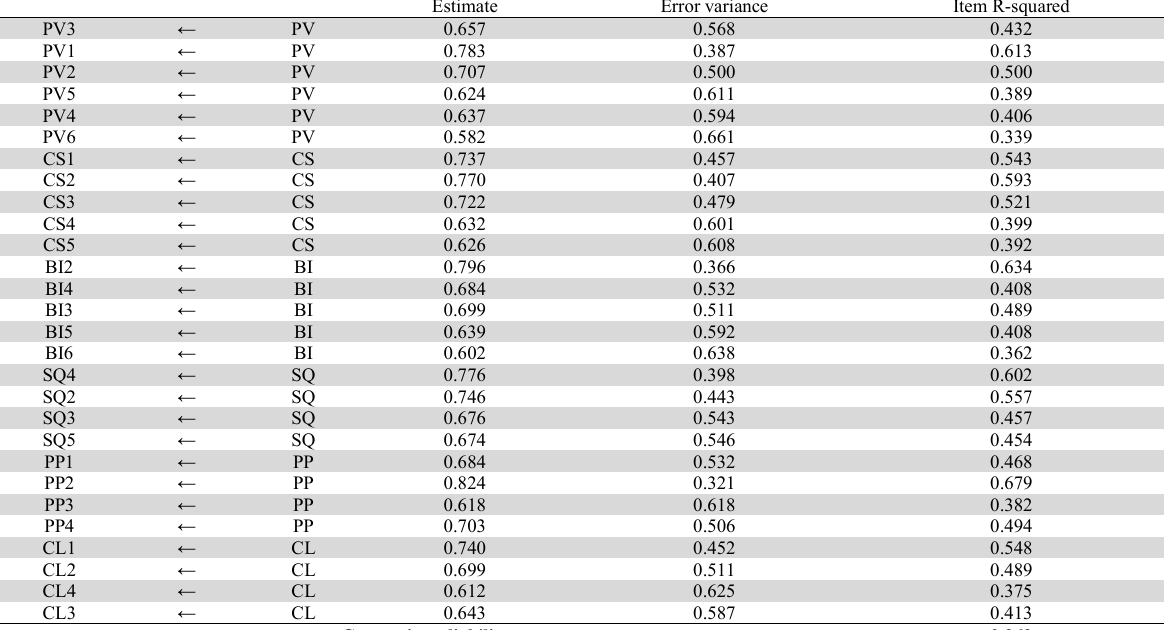
Composite reliability